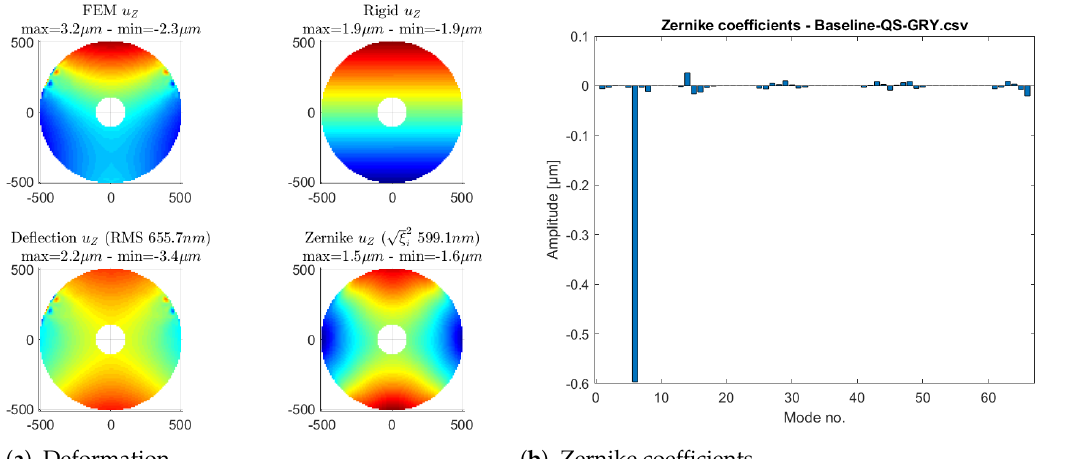
Figure 5. Baseline design with in-plane loading and outside